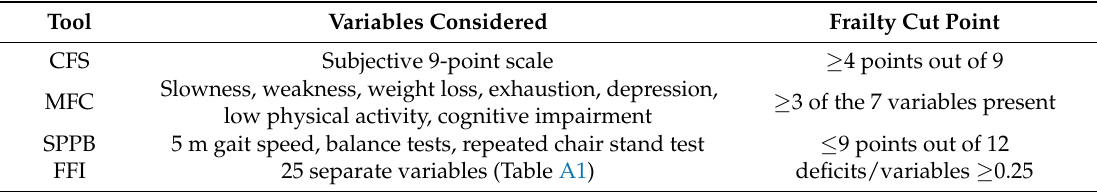
Table 1. Frailty measurement tools and cut